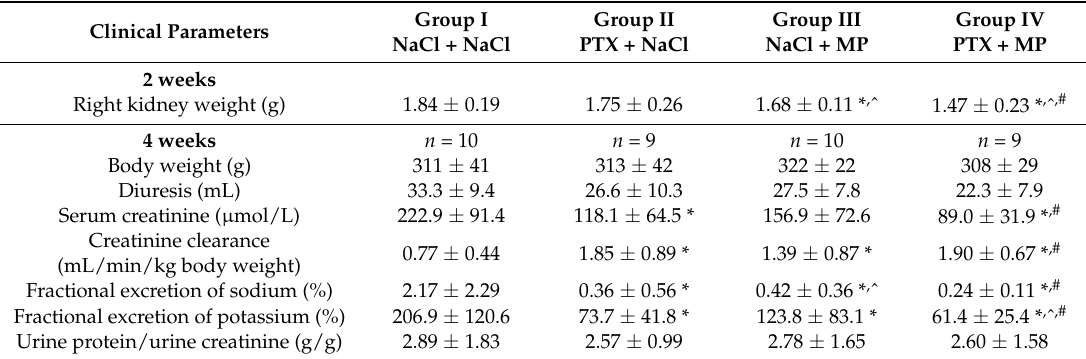
Table 3. Chronic kidney disease model—renal function parameters at 4, 16 and 24 weeks after the prolonged ischemia of left kidney with subsequent excision of right kidney at 2 weeks after left kidney ischemia-reperfusion.